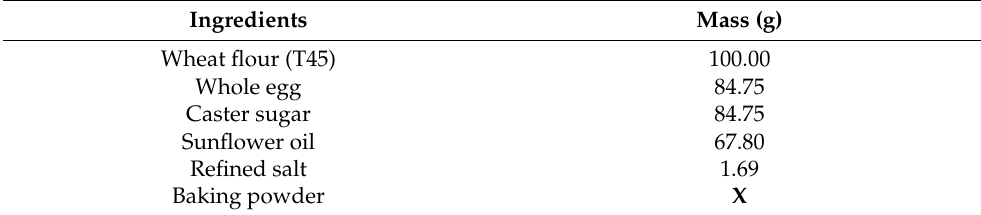
Table 1. Pound cake batter recipe based on 100g of wheat flour.